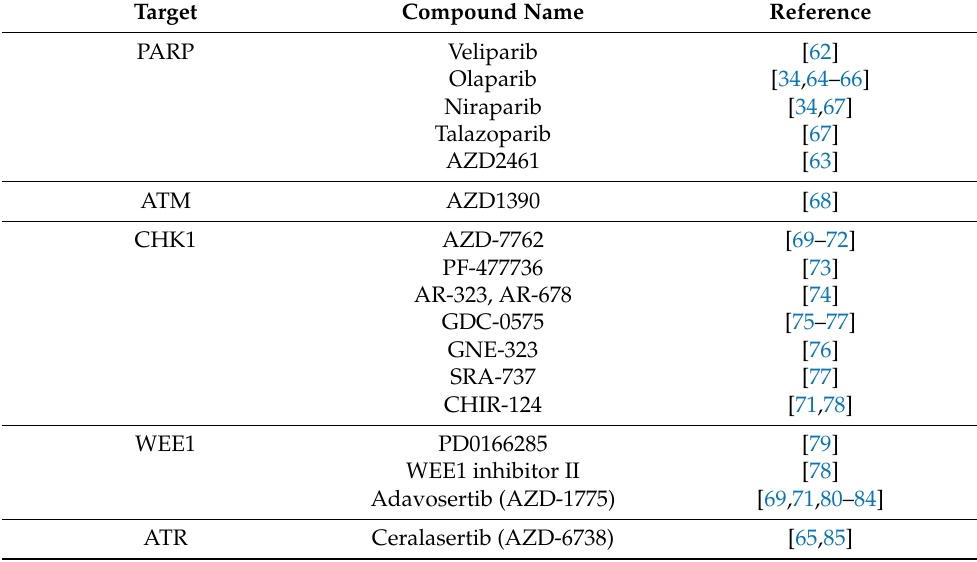
Table 1. DDR inhibitors with preclinical proof of cytotoxic and anti-tumor effects in melanoma.